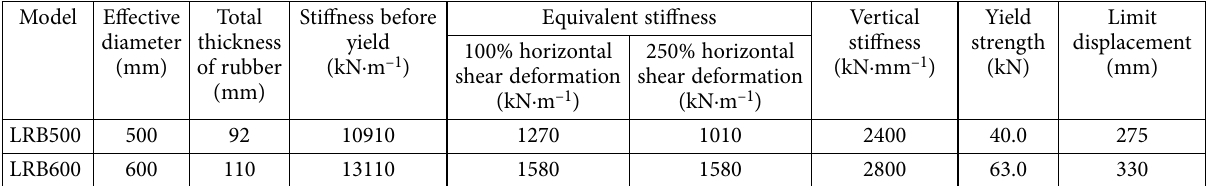
Table 3. Parameters of isolated